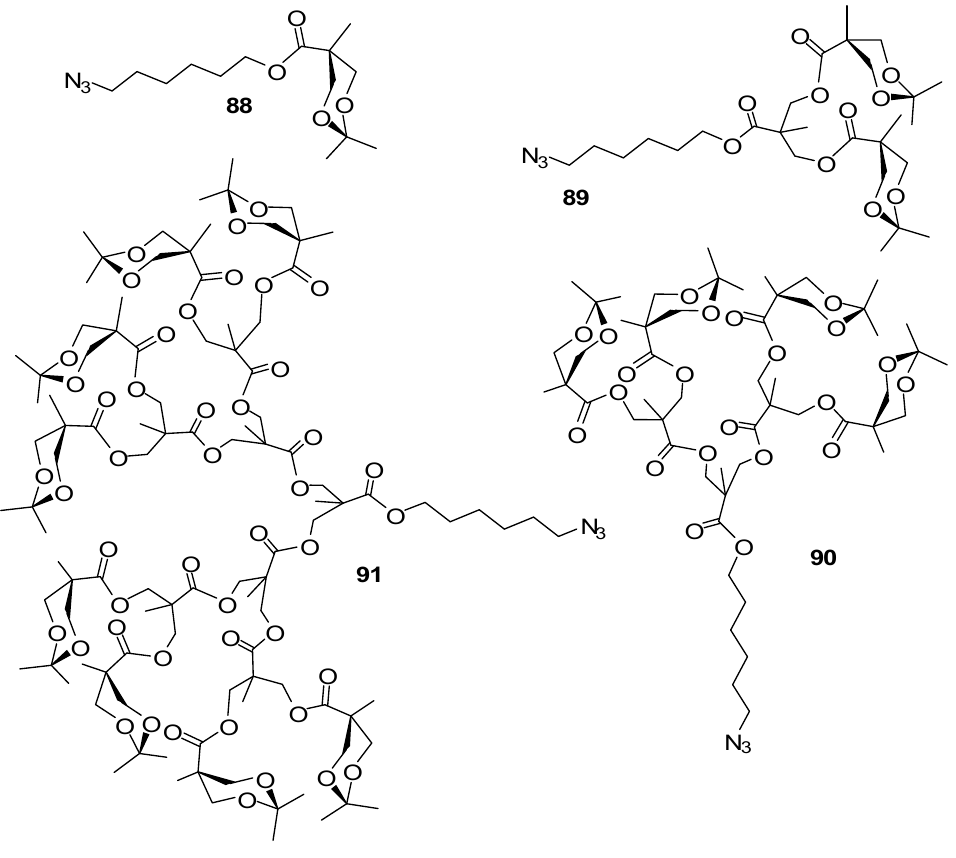
Figure 7. Azide-functionalized polyester dendrons